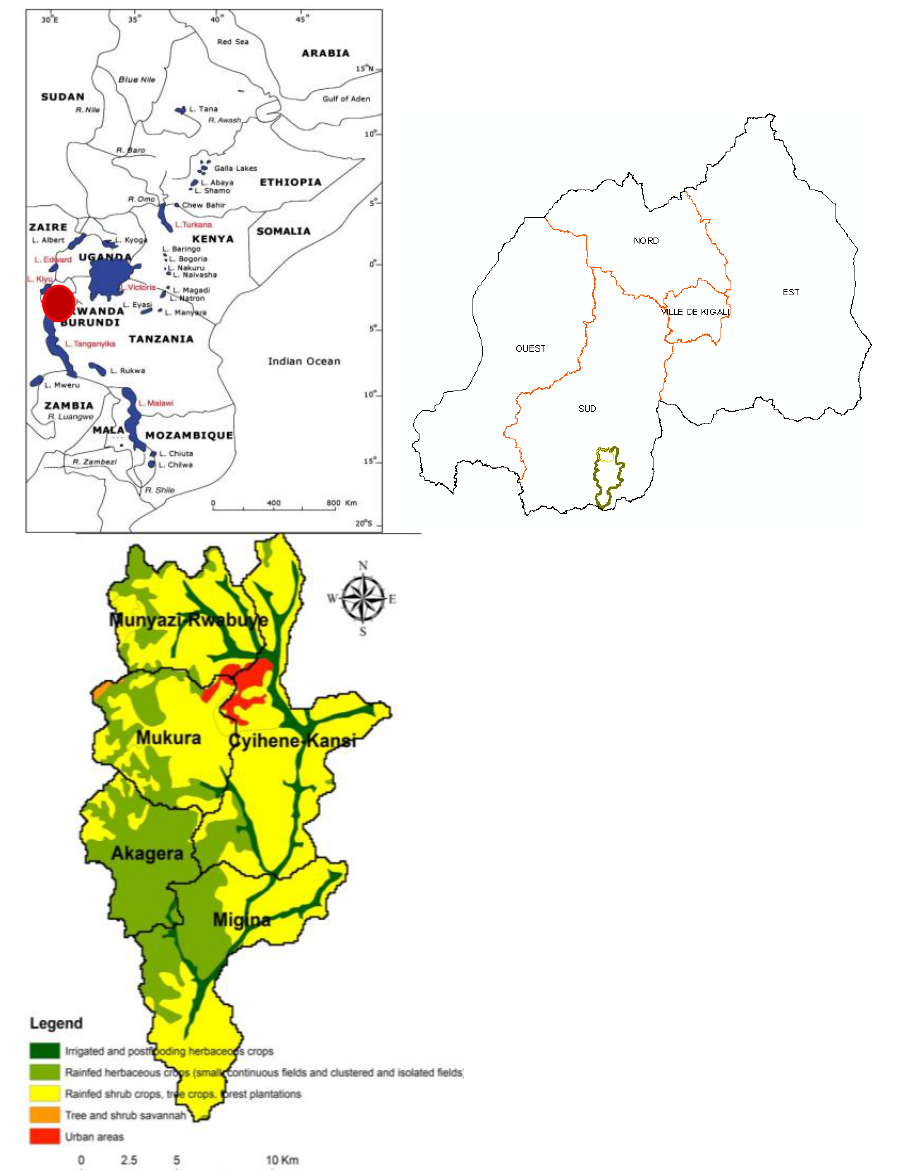
Figure 1 Location of Rwanda in the Africa (see a dot in red color) and location, land use and sub-catchments of the Migina catchment in the Rwandan map. Figure 1. Location, land use and sub-catchments of the Migina Catchment within Rwanda administration